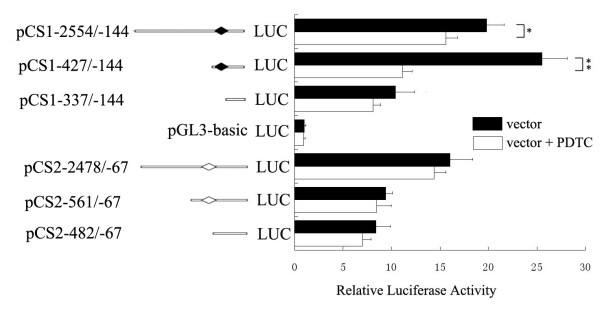
The differential effects of PDTC on the activity of mouse CS1 and CS2 gene promoter fragments harbouring 5' deletions. At 24 hours after transfection with reporter constructs, C2C12 cells were treated with PDTC (10 μM) for a further 24 hours, and the firefly luciferase activities were measured and normalized to the Renilla luciferase controls. The data values are the fold-increases (mean ± SD) in luciferase activity for each treatment over the basic luciferase vector sample activity without PDTC, and are the results of triplicate experiments. The statistical significance of the differences between the basal transcription and PDTC exposure values were analyzed by the Student's t-test, * P < 0.05, ** P < 0.001.